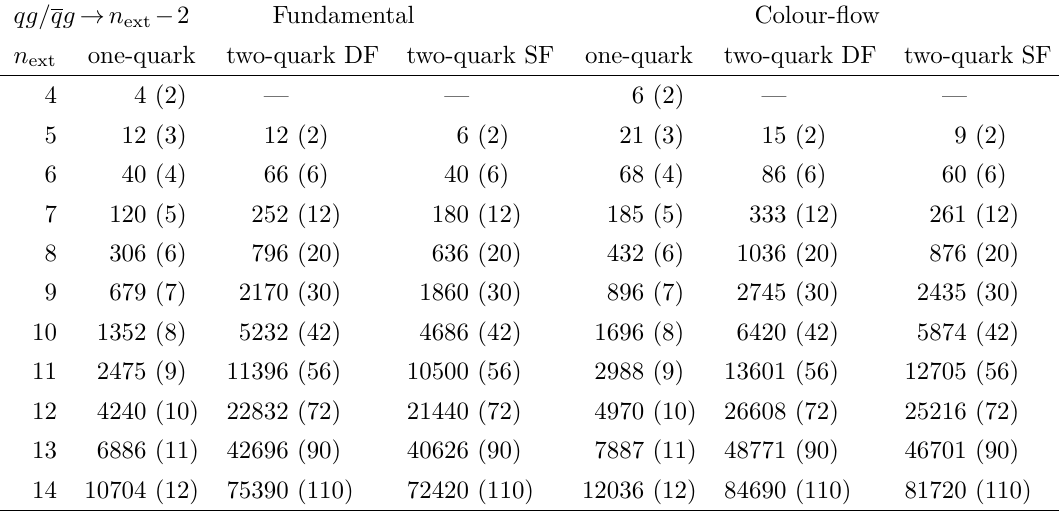
Table 8 . Number of non-zero elements in the colour matrix at NLC and at LC (in parenthesis) including the reduction due to the phase-space symmetrisation, for qg/qg initial states for one- quark-pair and two-quark-pair (same-flavour (SF) and distinct-flavour (DF)) processes for various numbers of final-state particles ( n 2 ) in the fundamental and colour-flow representations. ext −